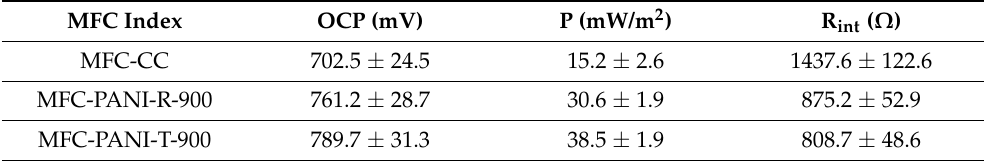
Figure 4. Polarization and power density curves of MFC with CC and PANI-R-900- and PANI-T- 900-modified anodes. Table 2. Average values of open circuit potential (OCP), power and current density and internal resistance of MFC modified with PANI-R-900 and PANI-T-900 and MFC with CC anode .